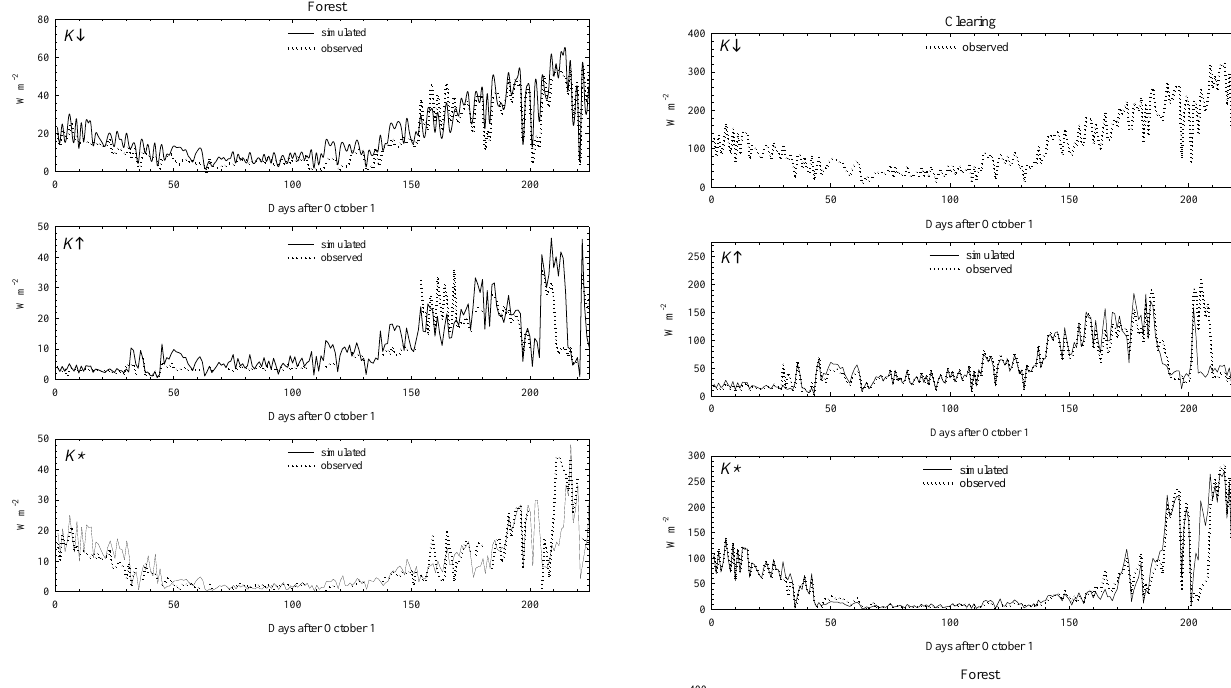
Fig. 6. Time series plots of mean daily simulated and observed shortwave ( K ) and longwave ( L ) radiation fluxes, as well as total net radiation to snow ( Q n ) at pine forest and clearing sites at Mar- mot Creek, Alberta,